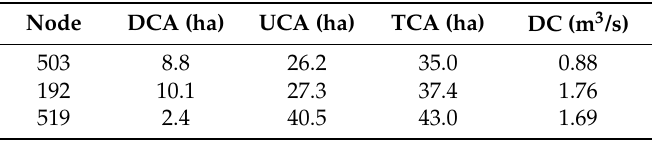
Table 4. Direct Catchment Area (DCA), Upstream Catchment Area (UCA), Total Catchment Area (TCA), and Drainage Capacity (DC) of the three selected nodes.